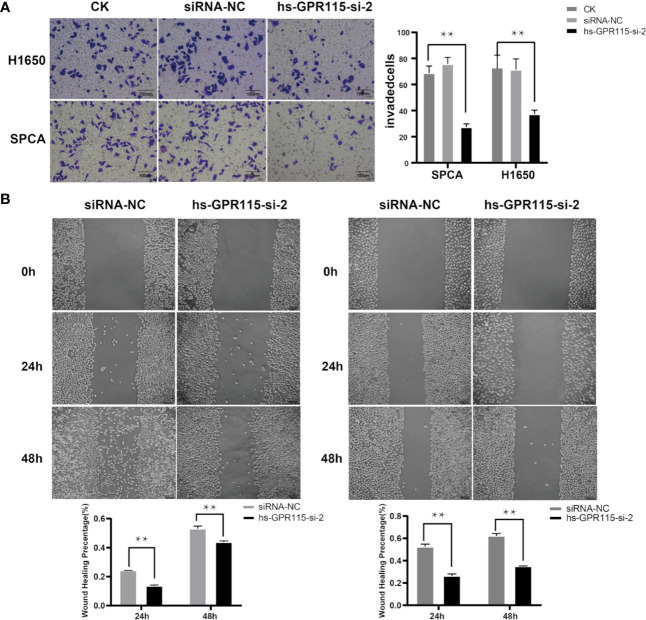
Effect of GPR115 on migration and invasion of LUAD cells. (A) Silencing GPR115 by hs-GPR115-si-2 reduced cell invasion by Transwell assay in H1650 and SPCA cell lines, respectively (Typical photomicrographs are presented). (B) Down-regulated of GPR115 inhibited the migration of LUAD cell lines by wound-healing assay. The scale bar means 100 μm. Data are presented as means ±SD, ** P < 0.01.